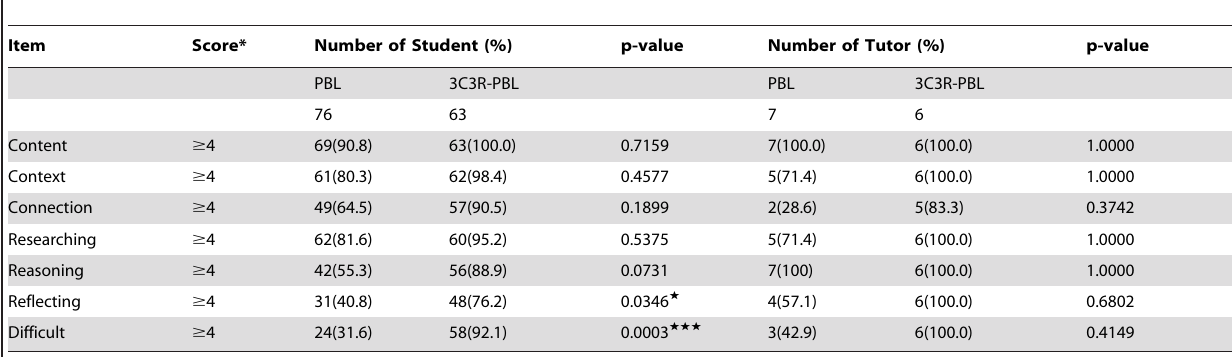
Table 2. Comparison of traditional PBL and 3C3R-PBL questionnaire survey results from students and tutors.